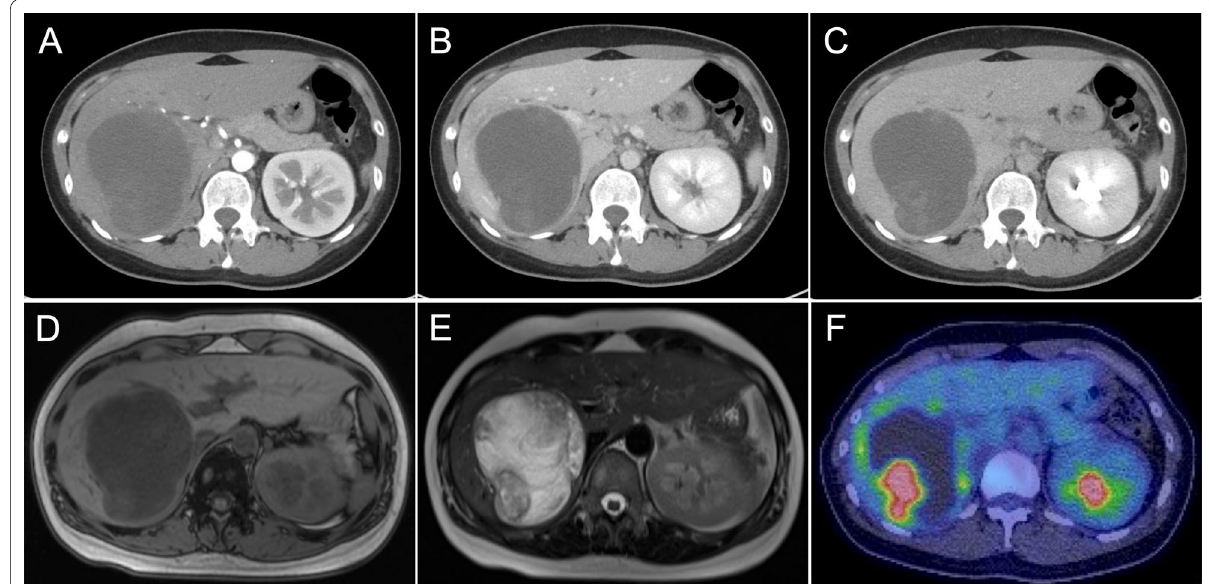
Fig. 1 Preoperative imaging findings. CT imaging demonstrating the hepatic tumor (axial section): A arterial phase, B portal phase, and C equilibrium phase. MRI imaging demonstrating the hepatic tumor: D T1-weighted and E T2-weighted images. F Positron emission tomography (PET)